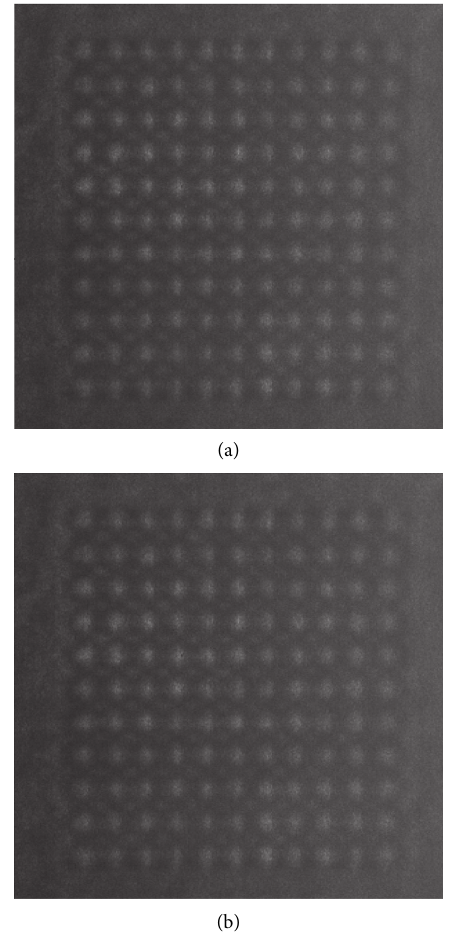
Figure 6: Experimental results. (a) Before the deformation. (b) After the